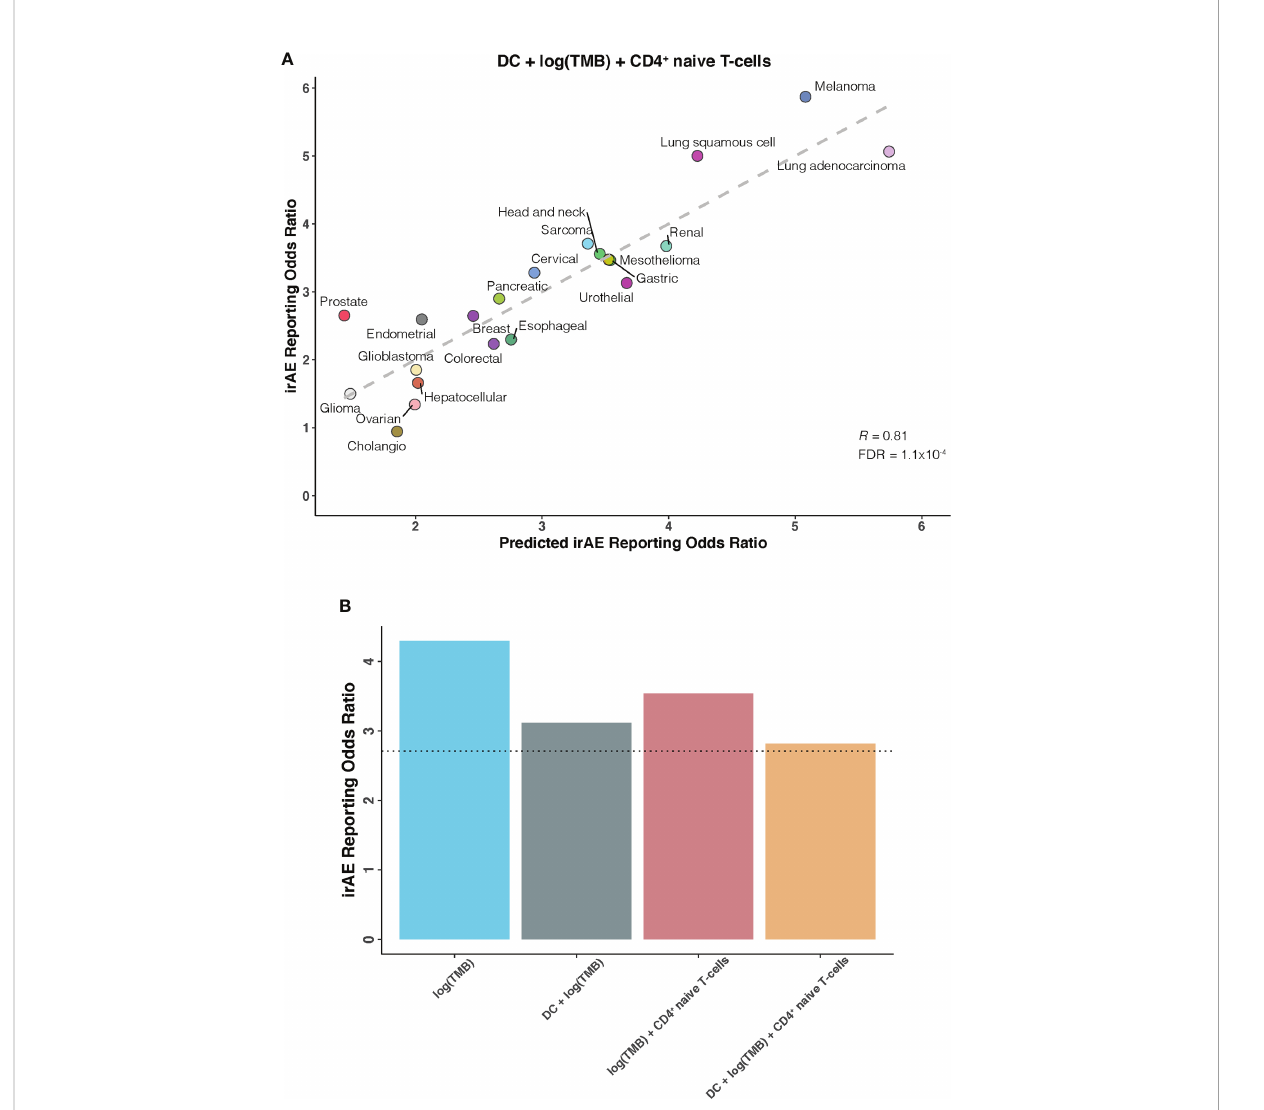
FIGURE 3 DC – TMB – CD4 + Naive T-cells Trivariate Model for Predicting Immune-Related Adverse Events for Anti – PD-1 Therapy Across Cancer Types (A) , Combined effect of dendritic cells abundance (DC) – tumor mutational burden (TMB) – CD4 + naive T-cells abundance (naiveCD4T) trivariate model. The dashed line depicts the linear fi t, with the formula reporting odds ratio (ROR) = 19.03 × DC + 0.82 × log(TMB) + 18.03 × naiveCD4T – 1.85. (B) , Estimated ROR to anti-PD-1 therapy in small cell lung cancer based on TMB univariate model, DC – TMB and TMB – CD4 + naive T-cells bivariate models, and DC – TMB – CD4 + naive T-cells trivariate model. The dotted line represents the ROR in small cell lung cancer, which was obtained using The US Food and Drug Administration ’ s Adverse Event Reporting